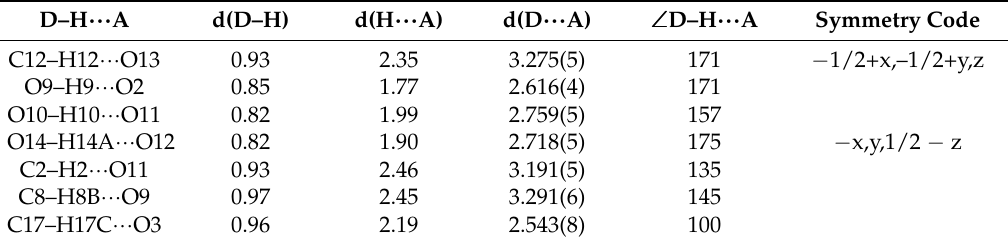
Table 3. Putative hydrogen bondings (Å), ( ◦ ) in the Co(II) coordination compound.